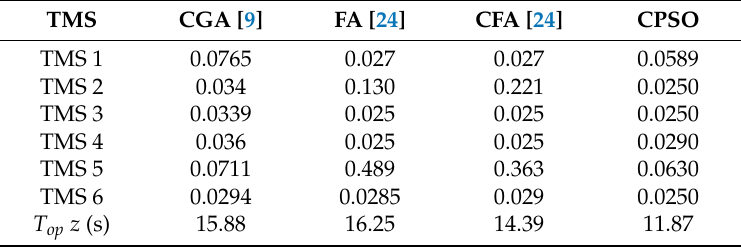
Table 17. Comparison of the optimized TMS by the proposed method with the literature for Case